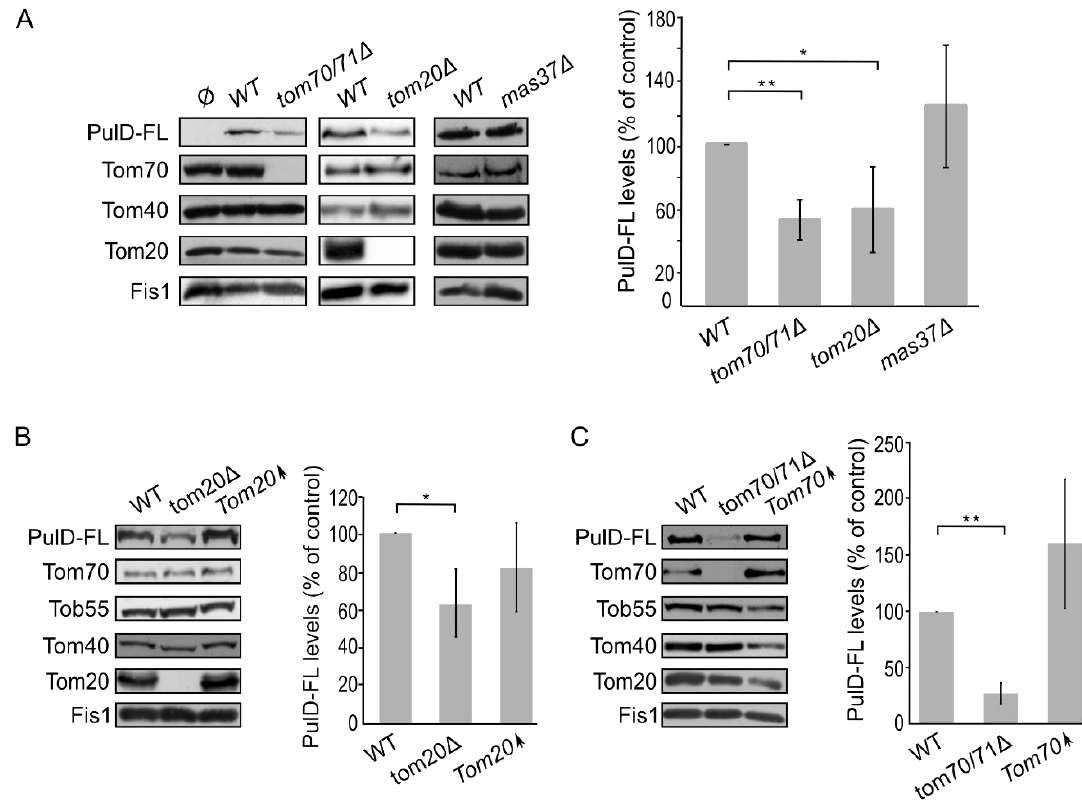
FIGURE 4: The assembly of PulD-FL in mitochondria depends on import receptors . (A) Left panel : Isolated mitochondria were obtained from the indicated strains transformed with either an empty vector (Ø) or a plasmid encoding PulD-FL. Samples were analysed by SDS-PAGE and immunodecoration with the indicated antibodies. Right panel: the steady state levels of PulD-FL in at least three experiments as in the left panel were quantified. The signal of Fis1 was taken as a loading control. Levels of PulD-FL in the corresponding wild type (WT) cells were set to 100%. The bar diagram shows the mean values ± s.d. of at least three independent experiments. (*, P < 0.05; **, P < 0.01; two tailed Student's t‐test). (B) Left panel : Crude mitochondria were obtained from WT, tom20 Δ , or a strain overexpressing TOM20 (Tom20↑) har‐ bouring a plasmid expressing PulD-FL. Samples were analysed by SDS-PAGE and immunodecoration with the indicated antibodies. Right panel : the steady state levels of the PulD- FL secretin were quantified and further analysed as described for part (A). (*, P < 0.05; two‐tailed Student's t‐test). (C) Crude mitochondria were obtained from WT, tom70/71 Δ , or a strain overexpressing TOM70 (Tom70↑) harbouring a plasmid expressing PulD-FL. Further treatment and analysis were as described in the legend of part